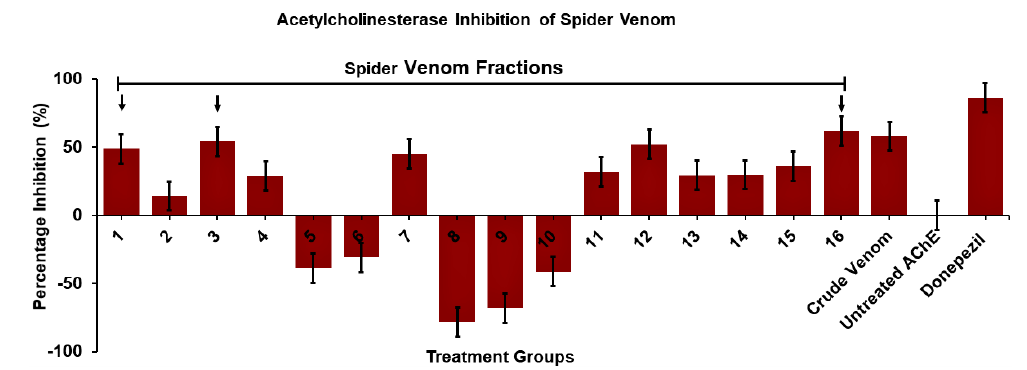
Figure 6. Screening for AChE inhibitory activities of whole and fractionated venom compared to untreated AChE reactions and Donepezil. Data are reported as mean ± SEM (bars). Note: *p < 0.05 significant differences against the negative control value (untreated AChE) (n = 3) (p = 0.965). Red arrows indicate the fractions with the highest AChE inhibitory activity.